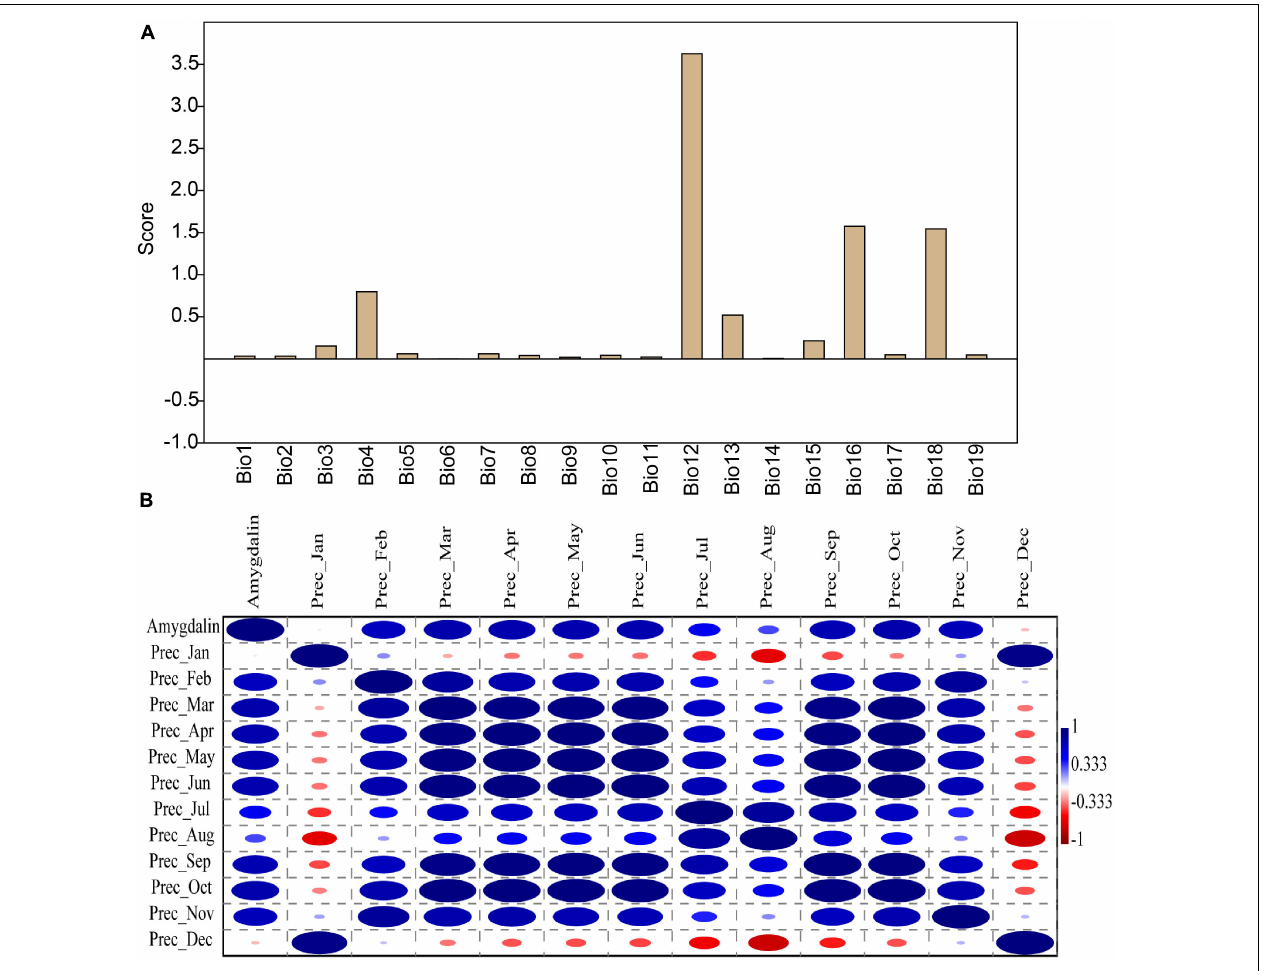
FIGURE 4 | Factor analysis scores of amygdalin content in 19 climate factor datasets (Bio1–Bio19) of six almond varieties (A) . Correlation analysis between amygdalin content and precipitation from January to December (B) . The correlation coefficients ranged from 1 (blue, positive) to -1 (red,